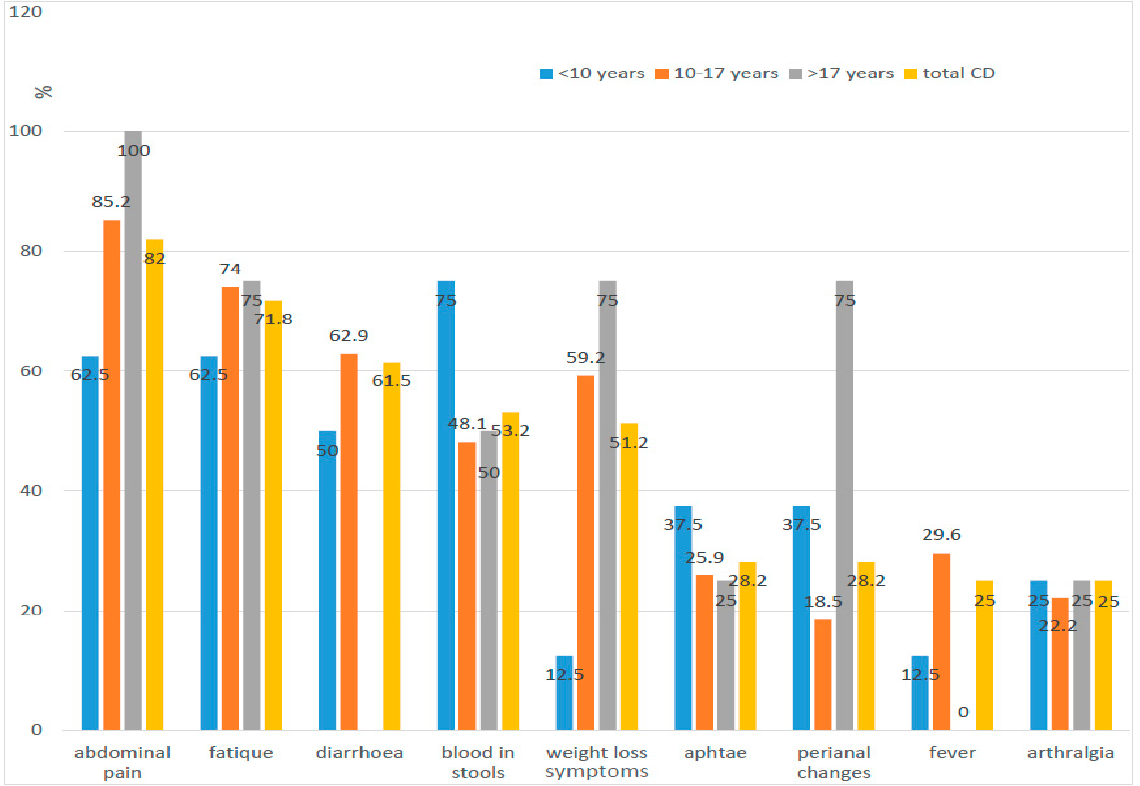
Figure 1. Gender structure: UC—ulcerative colitis; CD—Crohn’s disease; IBD—inflammatory bowel disease.